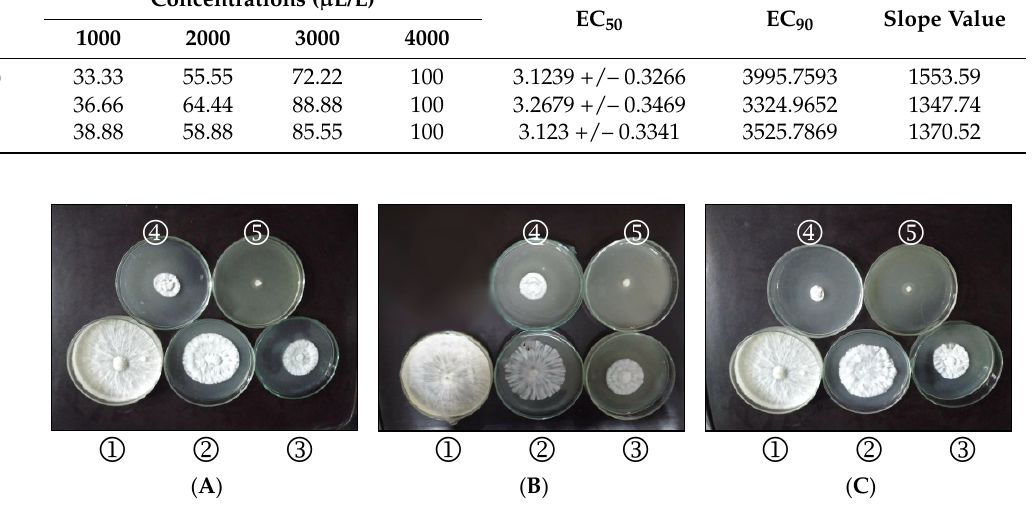
Figure 1. The antifungal activity of disinfectant agents in vitro measured by poisoned food technique. ( A ) Formulated phenol (7%); ( B ) chloroxylenol (10%); ( C ) phenic (10%). Control, 1000 µL/L, 2000 µL/L, 3000 µL/L, and 4000 µL/L.